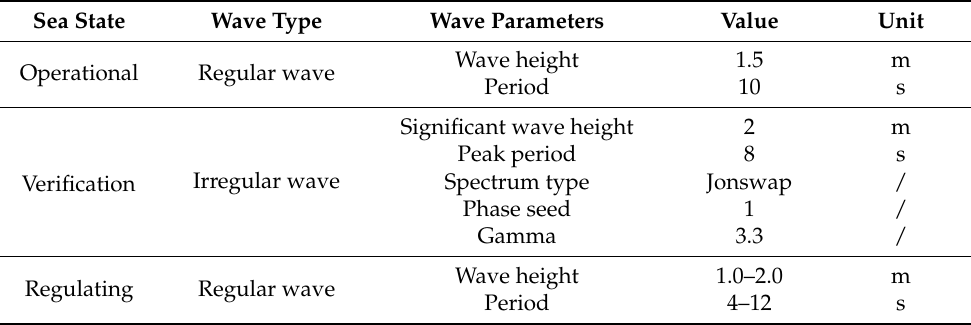
Table 1. Parameters of sea